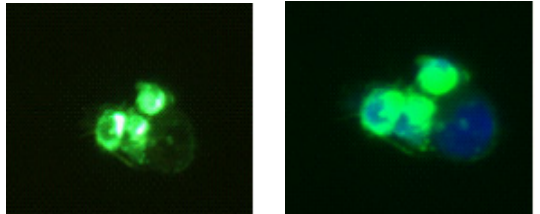
( A ) The location of SN-GFP-M by DAPI staining; Eyepiece magnification